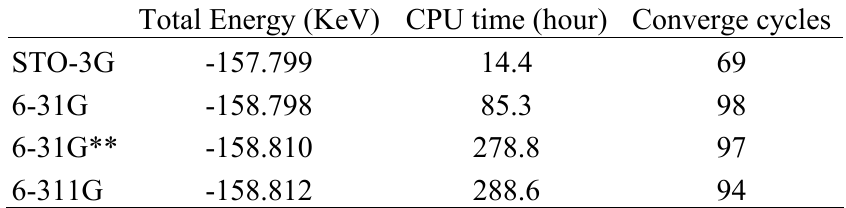
Table 3 The test results of the comparable basis sets for Cl, N, C and H